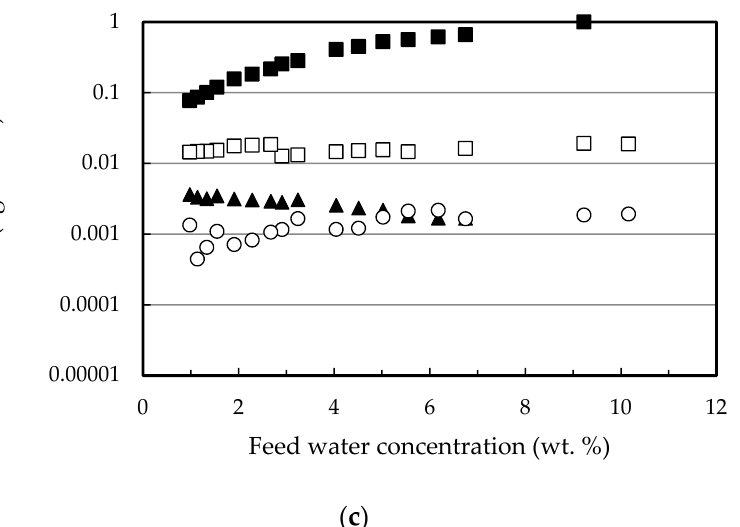
Figure 9. Individual component fluxes as a function of feed water content for the PERVAP™ 1131 membrane at: ( a ) 40 °C, ( b ) 60 °C, ( c ) 80 °C. ( ) Water, ( ) ethanol, ( ) ethyl lactate, ( ) lactic acid. Initial feed content: 13.5% lactic acid, 17.7% ethyl lactate, 10% water and 58.8% ethanol.